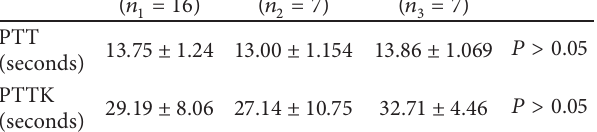
Analysis of variance. 𝑃 < 0.05 is